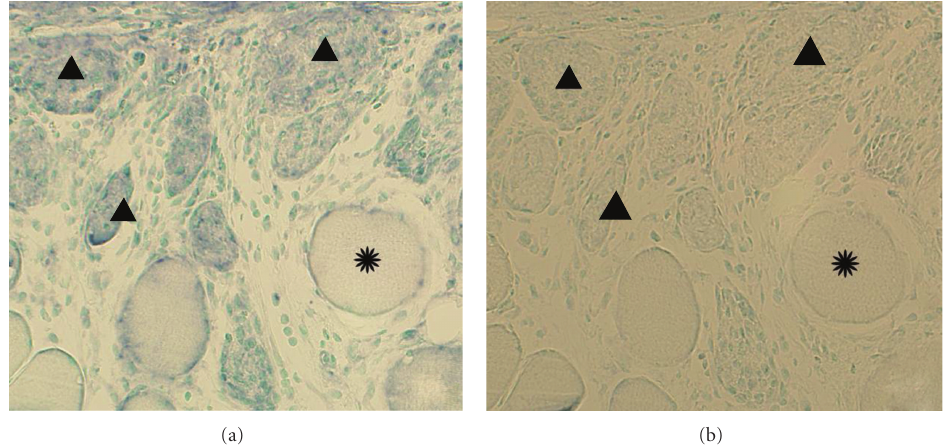
Figure 10: In situ hybridization for the demonstration of TNF-alpha mRNA in the muscle tissue. Adjacent sections are shown, one processed with antisense probe (a), the other with sense probe (b). There are reactions in muscle fibers in (a) but not in (b). Arrowheads indicate corresponding muscle fibers in (a) and (b). As verified via examinations of parallel sections processed for morphology, the reactive muscle fibers are infiltrated by inflammatory cells. Certain muscle fibers appear to be una ff ected (asterisk).